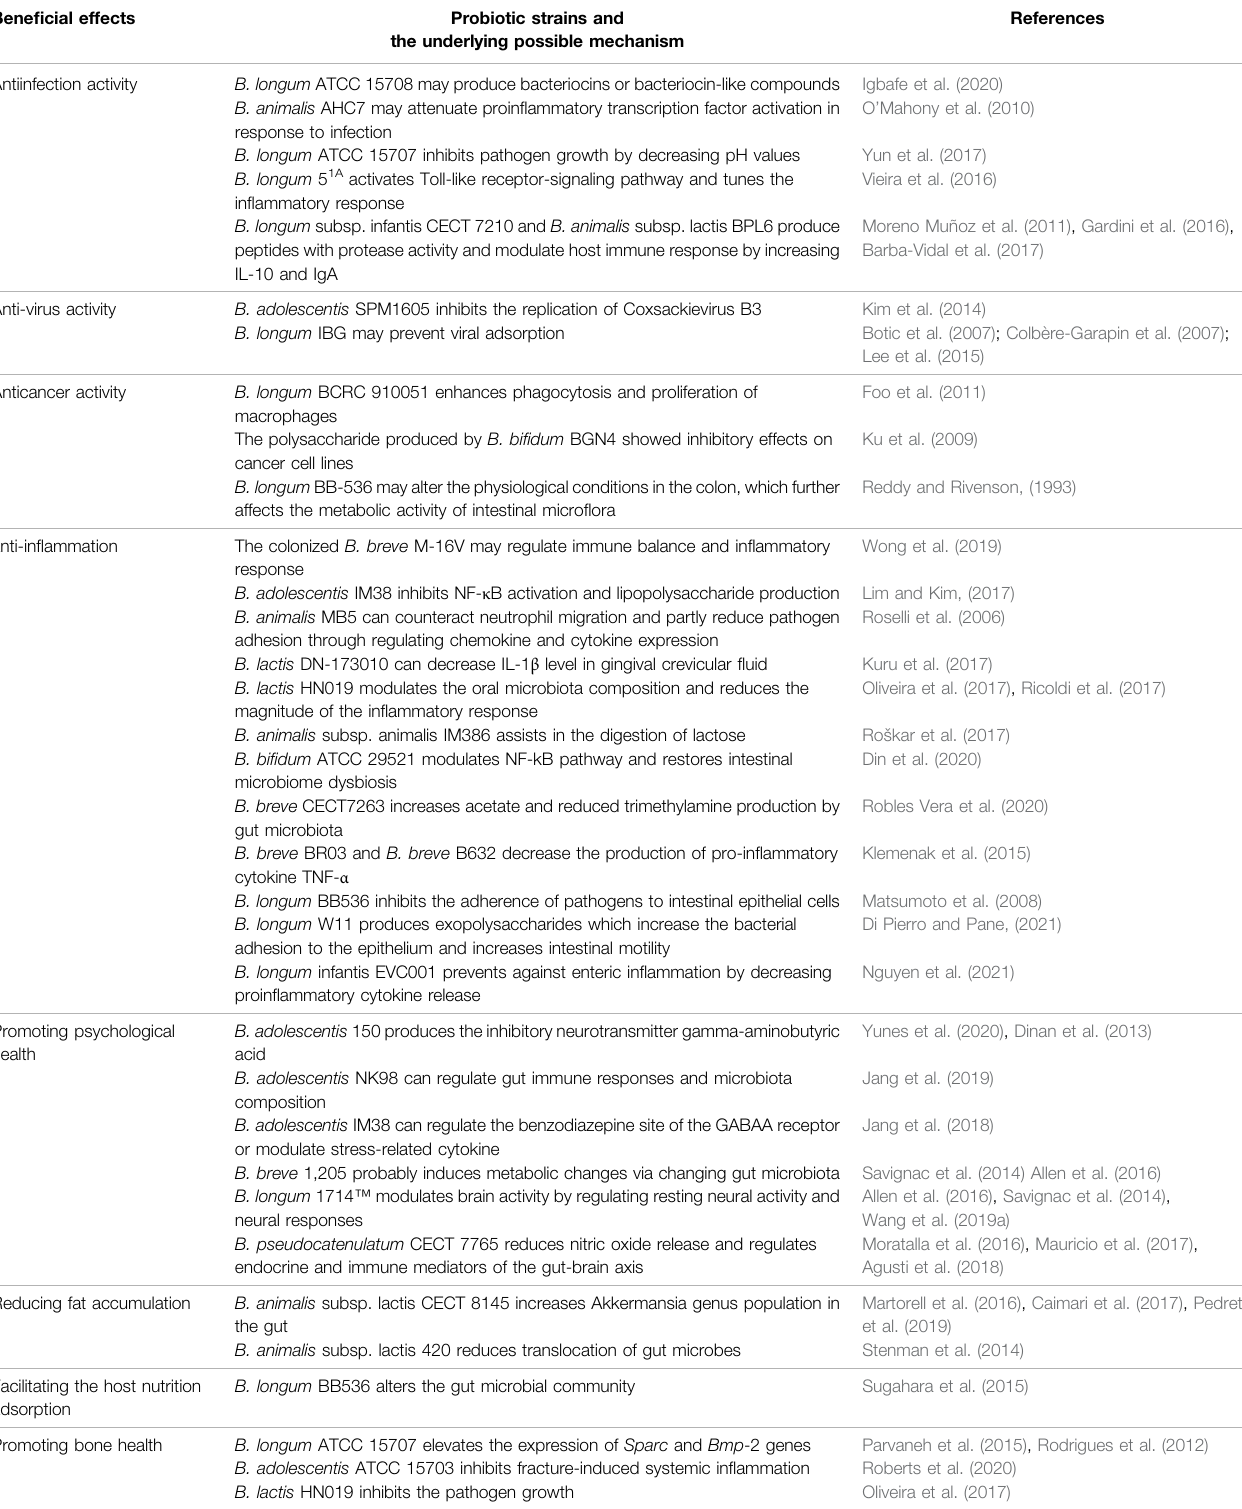
TABLE 1 | Bene fi cial effects displayed by common probiotic Bi fi dobacteria and the mechanisms